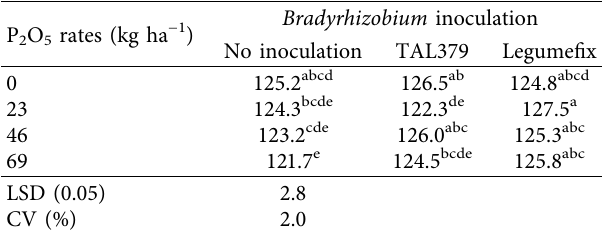
Table 3: Interaction effect of Bradyrhizobium inoculation with phosphorus application rates on days to physiological maturity of